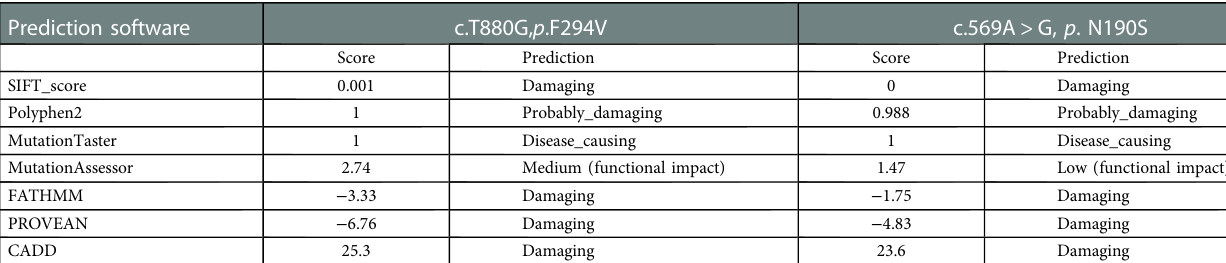
TABLE 2 Pathogenicity predictions of c. T880G, p . F294V and c.569A>G, p . N190S in CLCN7 gene. Prediction